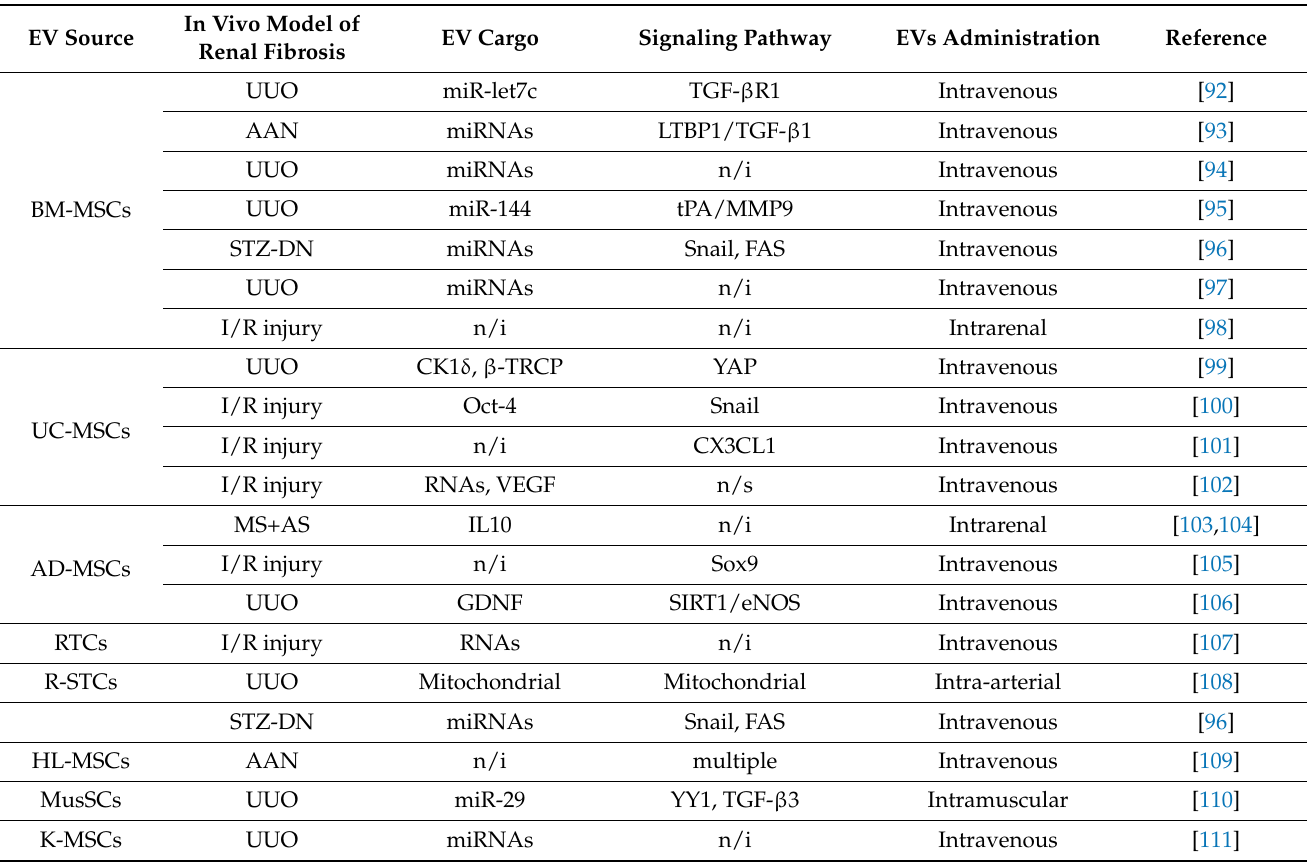
Table 1. Application of EVs as therapeutic agents in renal